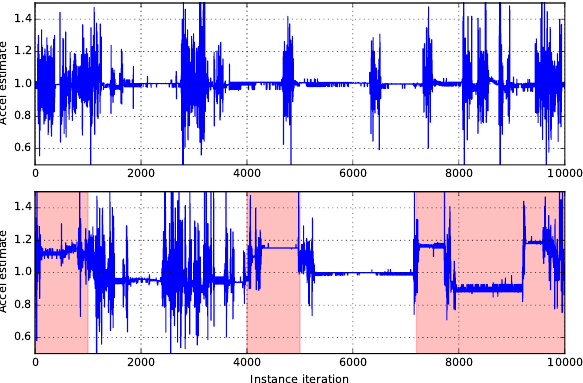
Figure 5. Calibrated accelerometer readings ( upper ) that were derived from raw (uncalibrated) accelerometer values ( lower ). The intervals shaded in red were used to perform